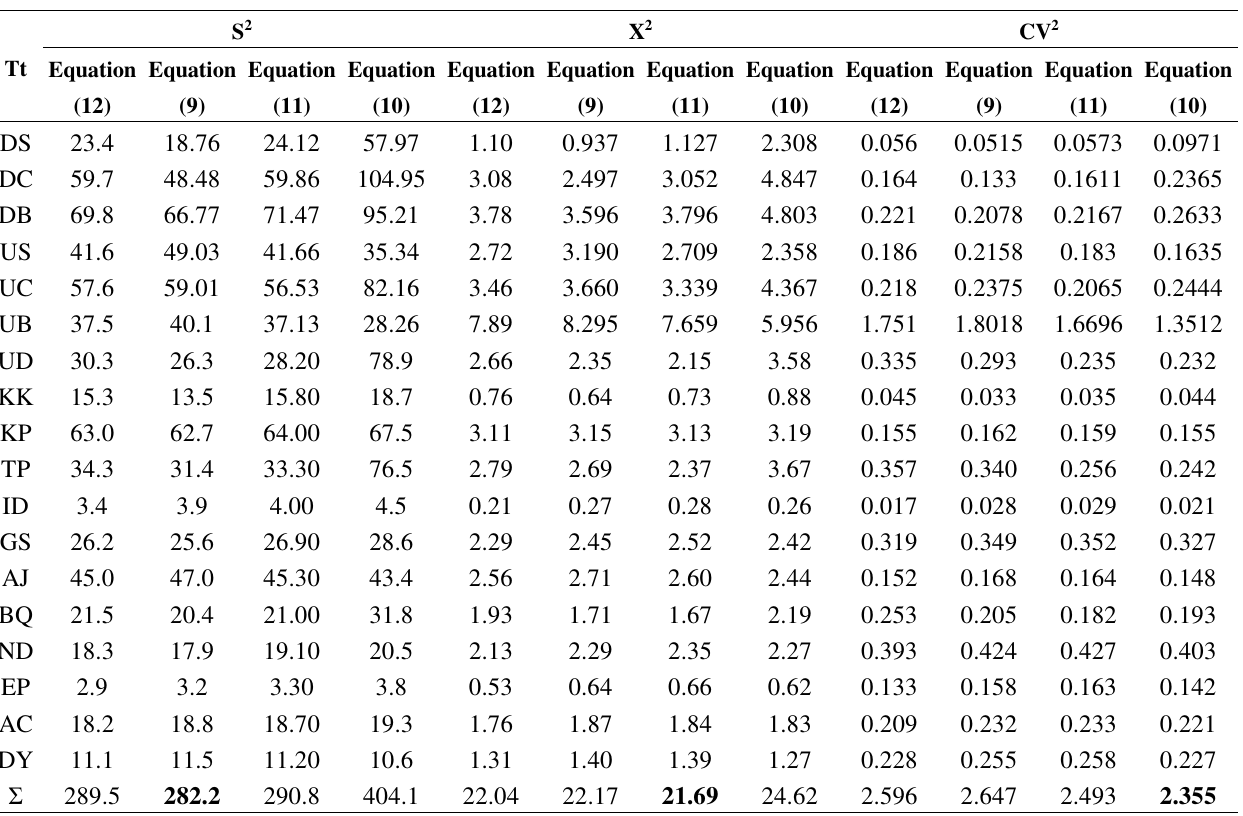
Table 7. Comparative value for chance experimental